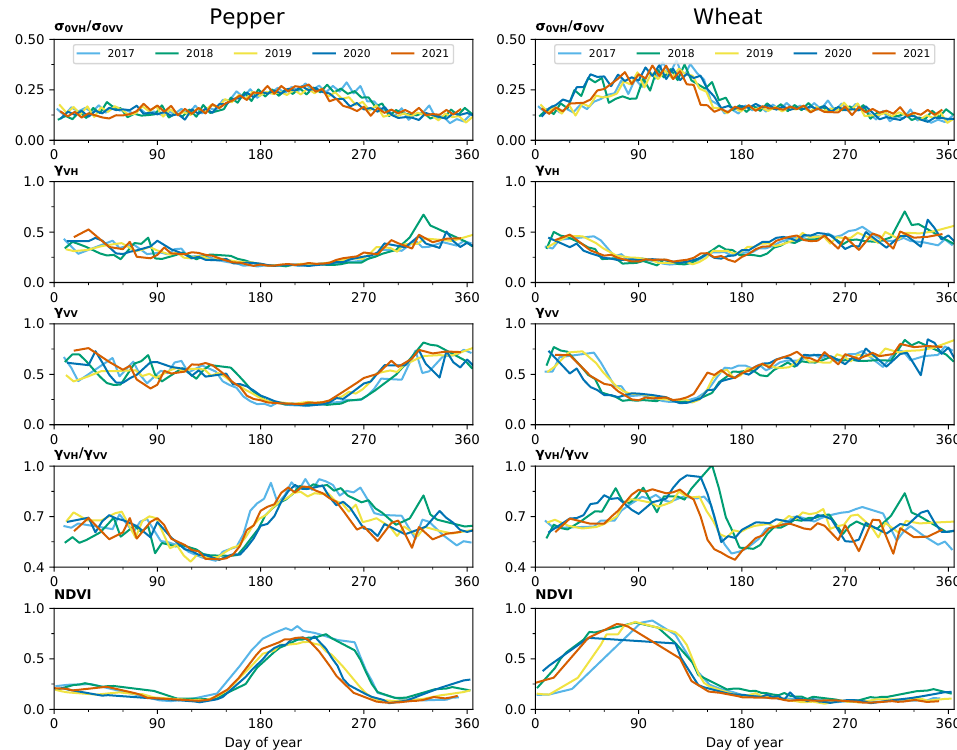
Figure 4. Yearly time series of backscattering, coherence amplitude and NDVI for two of the studied crops. The data points in each curve are the result of the averaging of values for all the pixels corresponding to the crop at each